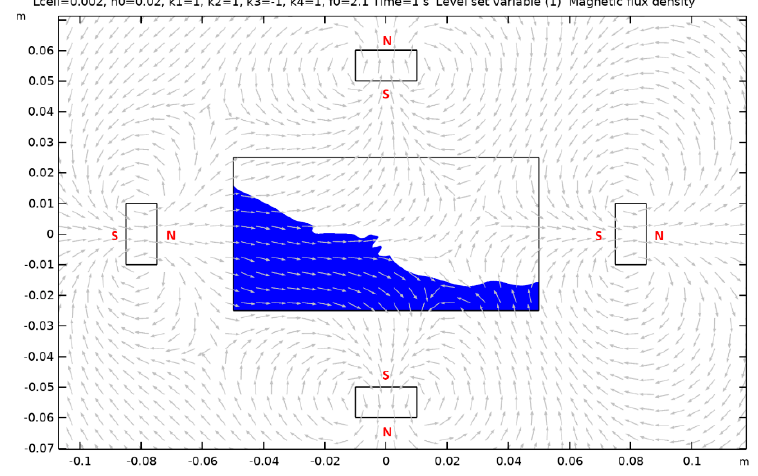
28 of 37 Figure A11. Case 12.